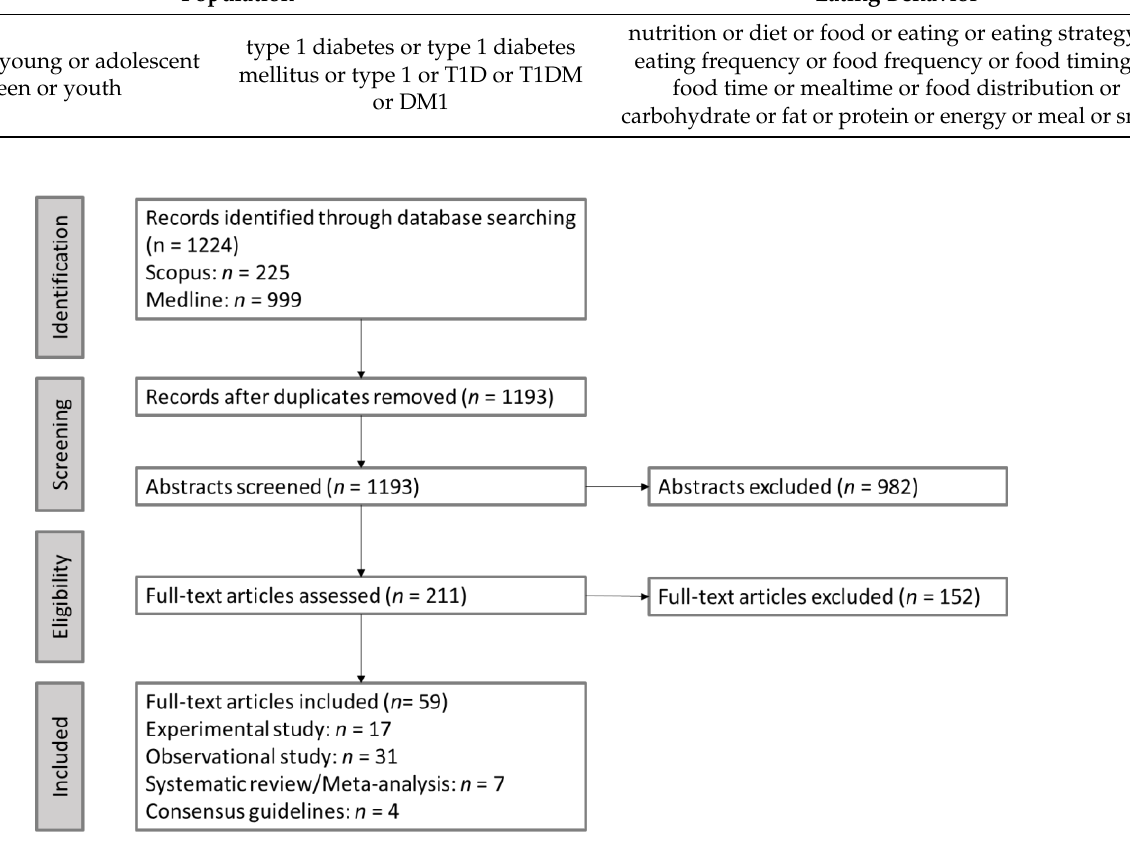
Figure 1. PRISMA Flow Diagram.